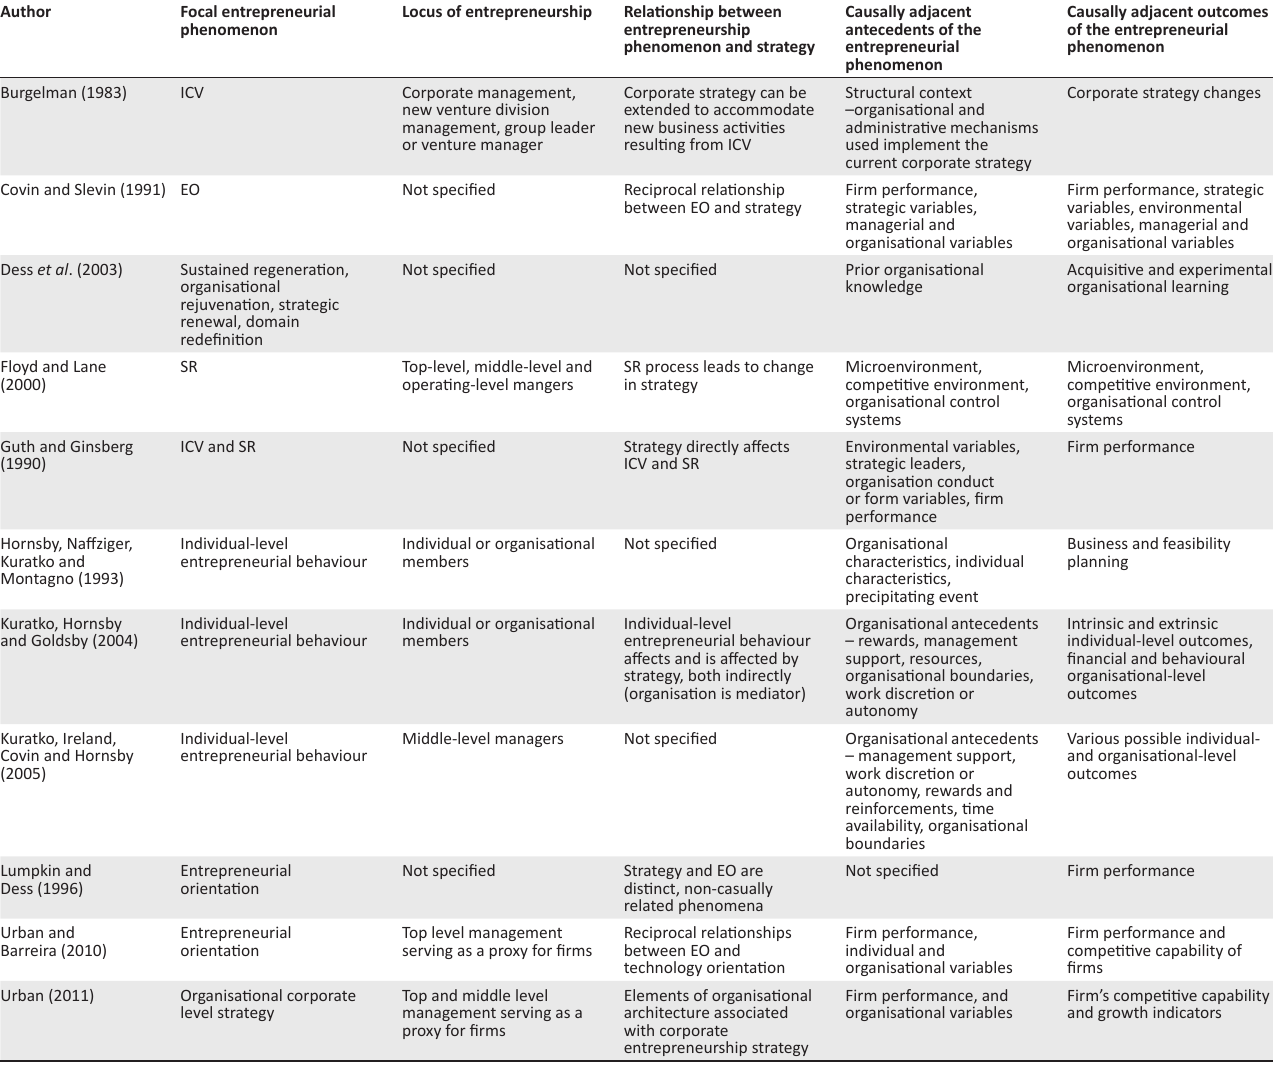
TABLE 1: Summary of entrepreneurial phenomena in established